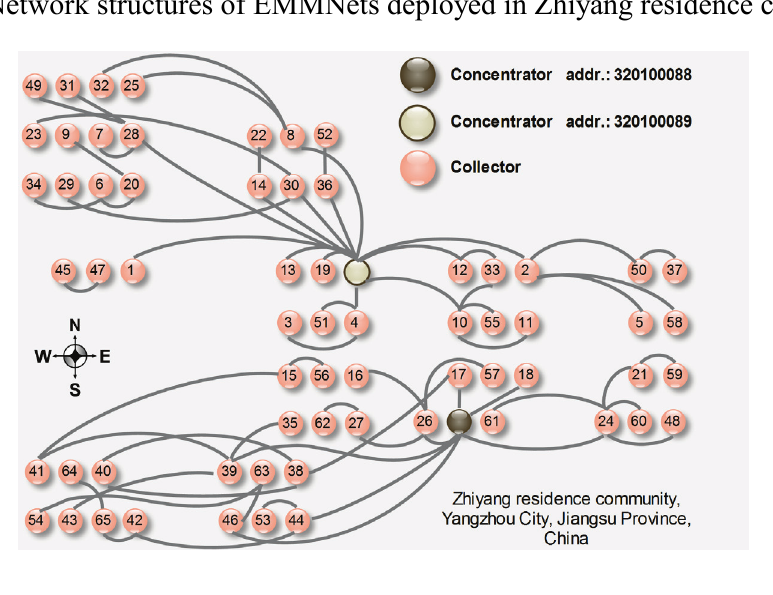
Figure 9. Network structures of EMMNets deployed in Zhiyang residence